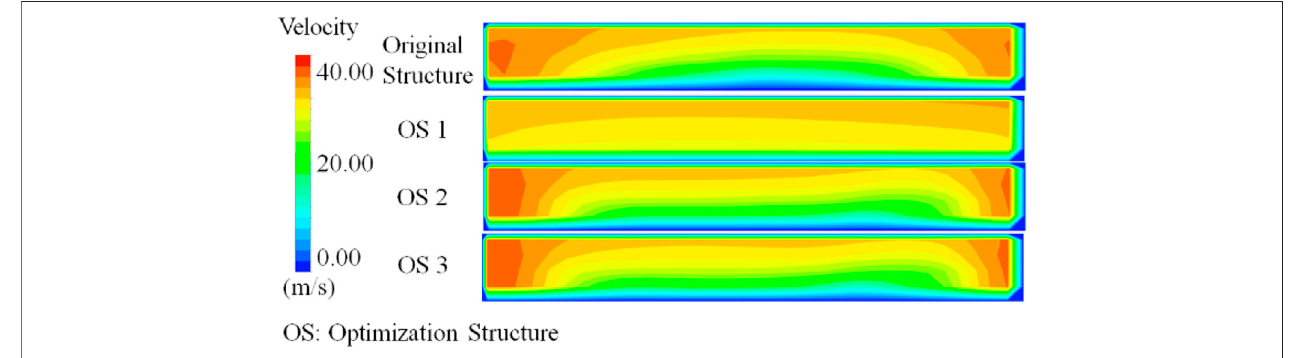
FIGURE 13 | The outlet section velocity results of different OS models.